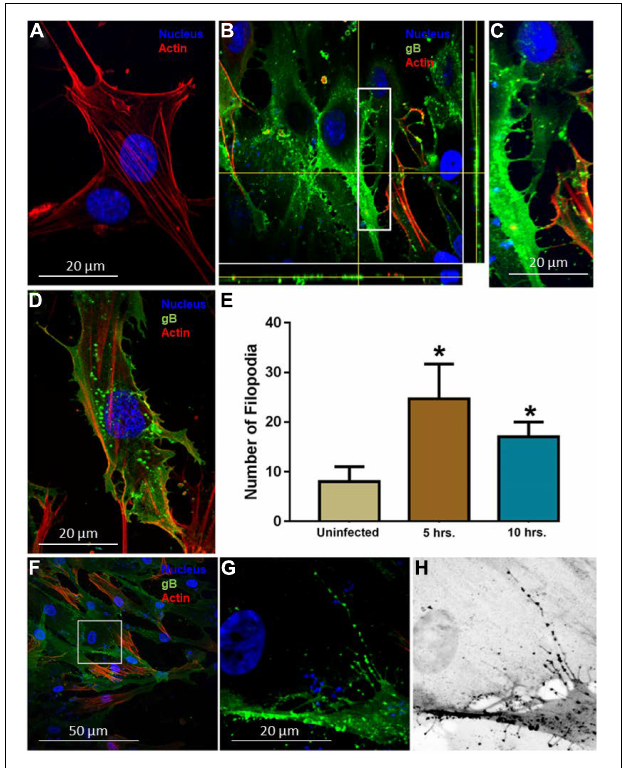
FIGURE 1 | Induction of filopodia in human iris stromal (HIS) cells upon HCMV infection. (A) Mock infected HIS cells. (B,C) HIS cells infected with HCMV at 10 multiplicity of infection (MOI) for 5 h. Immunofluorescence staining involving fluorescein isothiocyanate (FITC)-conjugated anti-gB antibody showed the presence of the virus inside the HIS cells using deconvolution imaging. The area boxed in (B) is highlighted in (C) showing a large number of virus particles at the cell body beneath filopodia. The cells were stained with phalloidin conjugated to rhodamine to detect filopodia, while nuclei were stained with 4,6-diamino-2-phenylindole (DAPI). (D) HIS cells infected with HCMV at 10 MOI for 10 h. At this time point, a large number of virus particles were localized near the nucleus, but filopodial protrusions remained visible. (E) Quantification of filopodia and its length were based on 15 cells randomly picked per triplicate experiment. Asterisks indicate significant difference from controls and/or treatments ( p < 0.05, t -test), and error bars represent SD. (F–H) Immunofluorescence imaging performed 60 min post-HCMV infection by using anti-HCMV glycoprotein B (gB) antibody in HIS cells. The area boxed in (F) is highlighted in (G) , and inverted gray scale image is projected in (H) . The presence of green punctate indicates HCMV particles present on